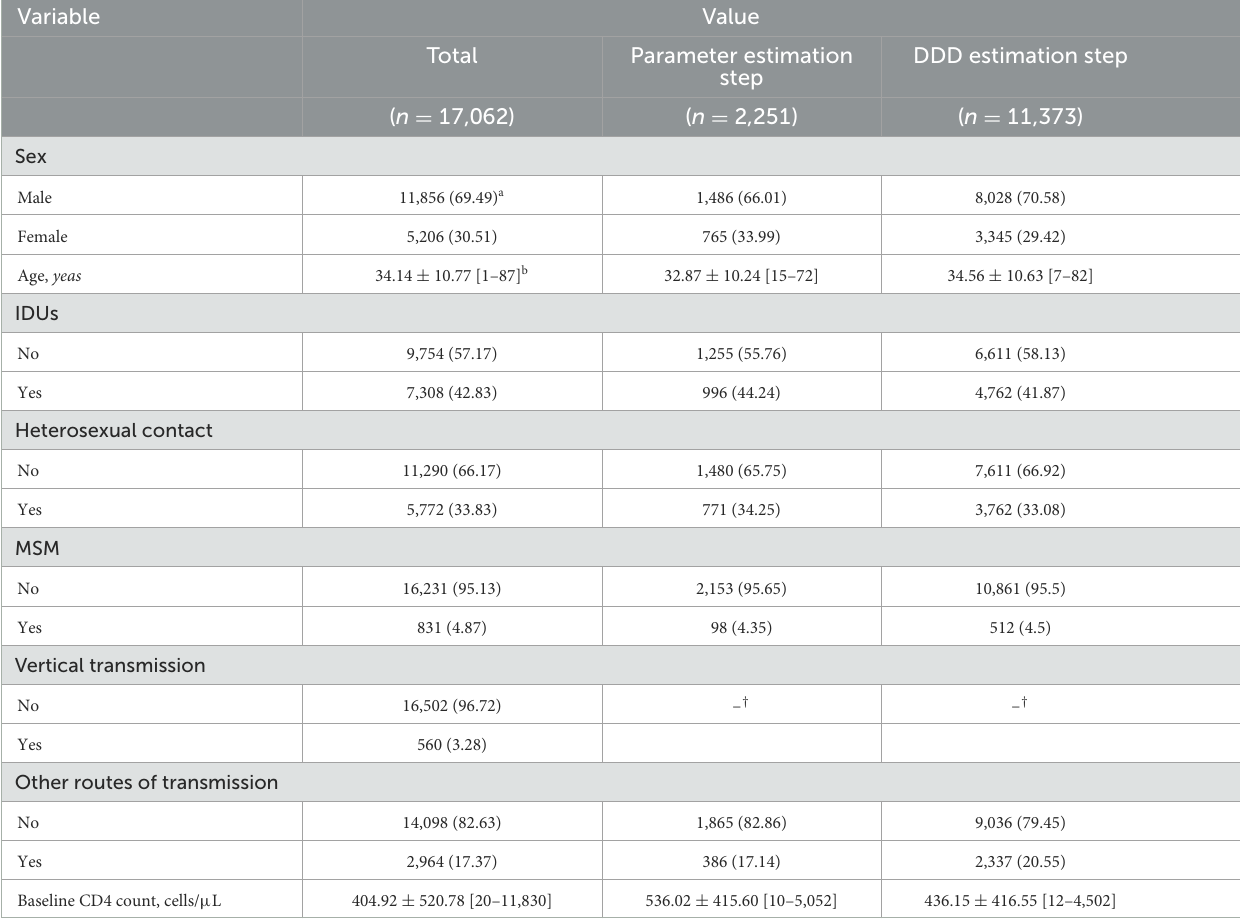
TABLE 1 Characteristics of the national HIV/AIDS surveillance system database (HASS) from 8 December 1993 to 16 March 2019.